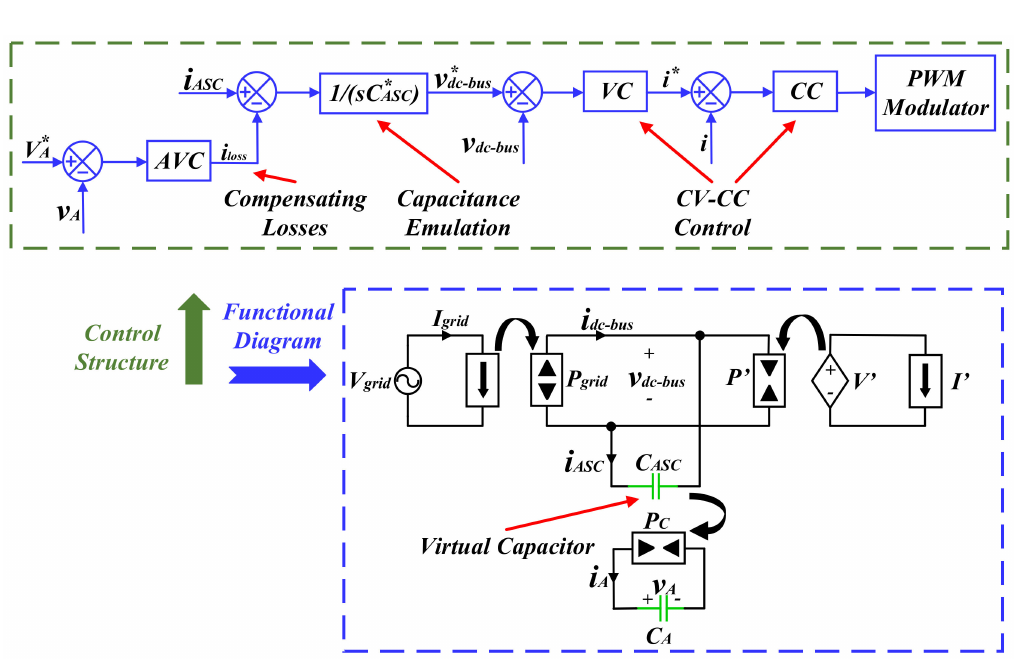
Figure 18. Capacitor dynamic behavior imitation strategy, control structure, and functional